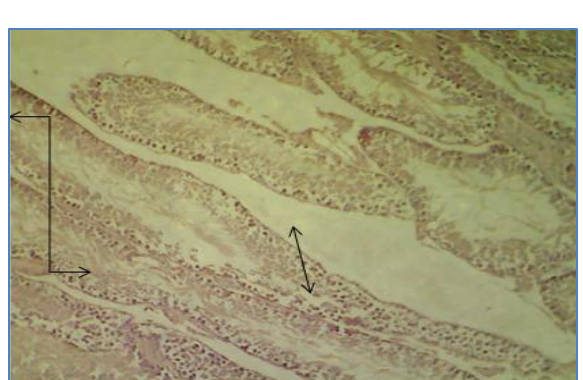
Figure, 11: Section in testis of animal treated with cadmium chloride (G1) shows most of them were shrinkage, irregular arrangement of seminiferous tubules ( ) and increase intertubular spaces ( ) (H and E stain 10X).